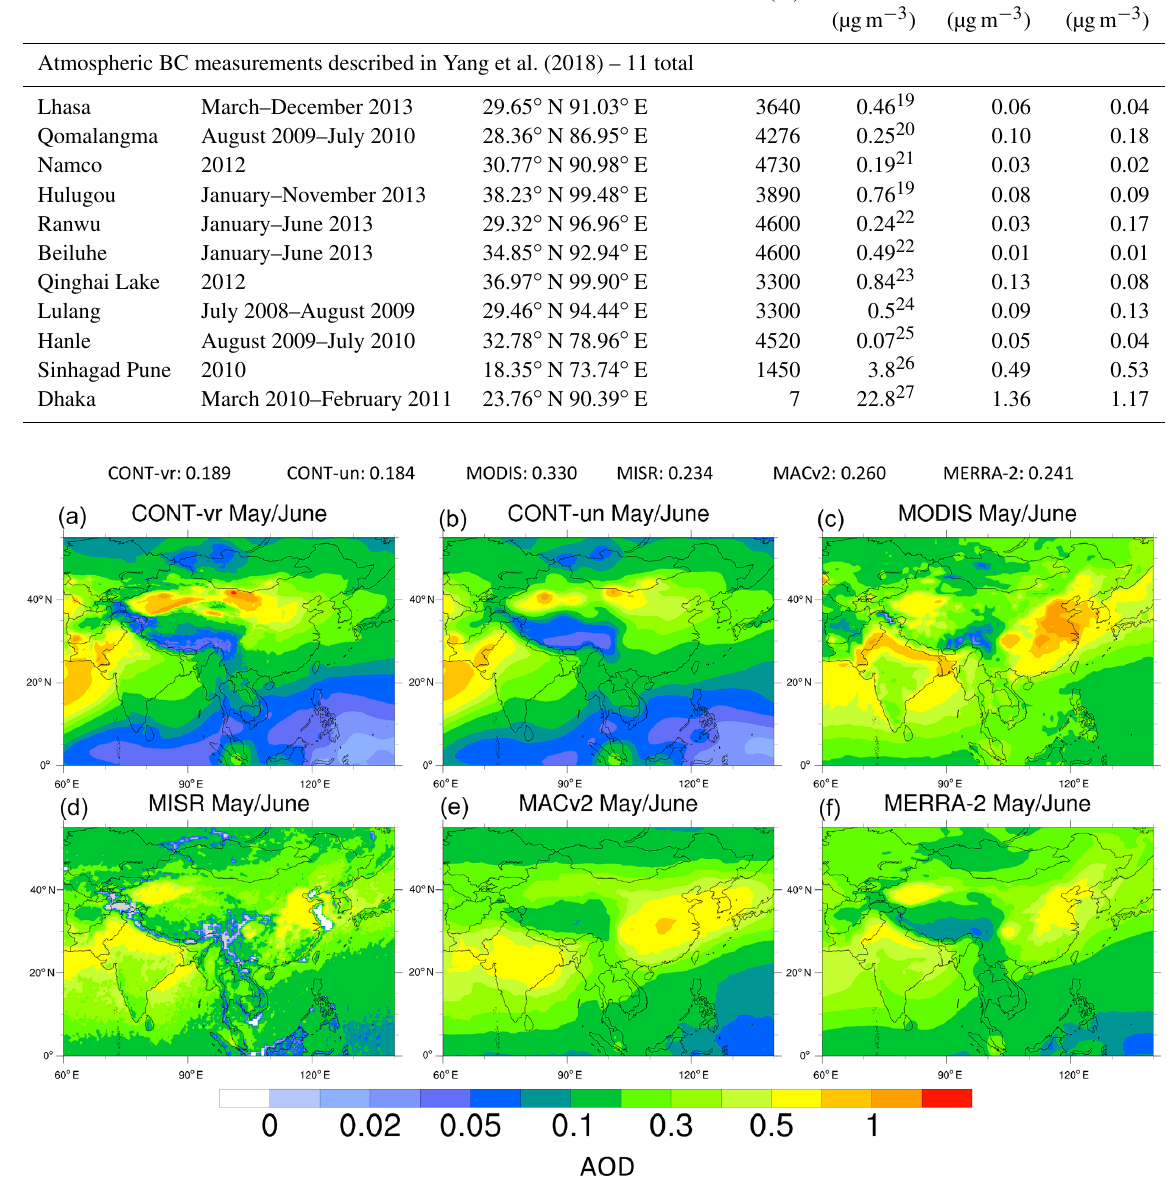
Figure 2. Panels (a) , (b) , (c) , (d) , (e) , and (f) depict May–June-averaged AOD values across South Asia for CONT-vr, CONT-un, MODIS, MISR, MACv2, and MERRA-2, respectively. AOD averages from these respective data between 0 and 60 ◦ N and 60 and 140 ◦ E are given at the